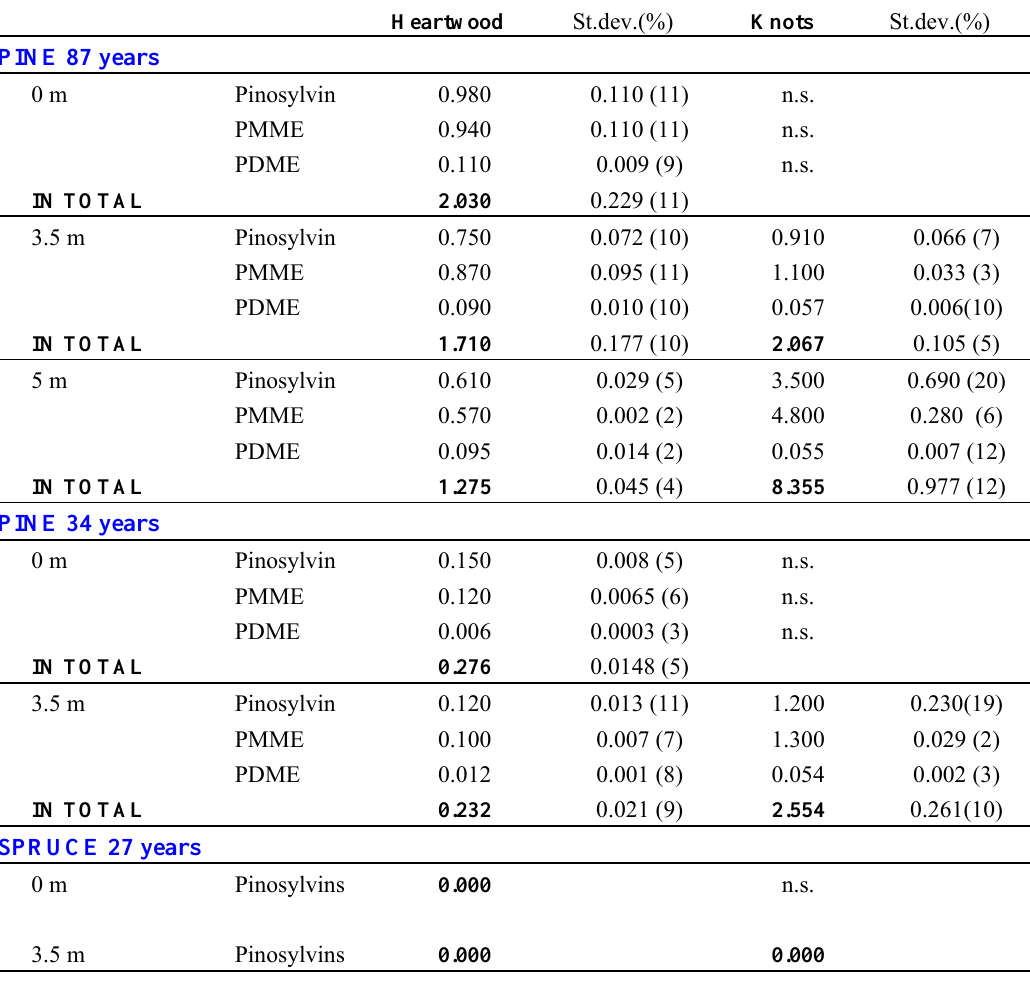
Heartwood St.dev.(%) Knots